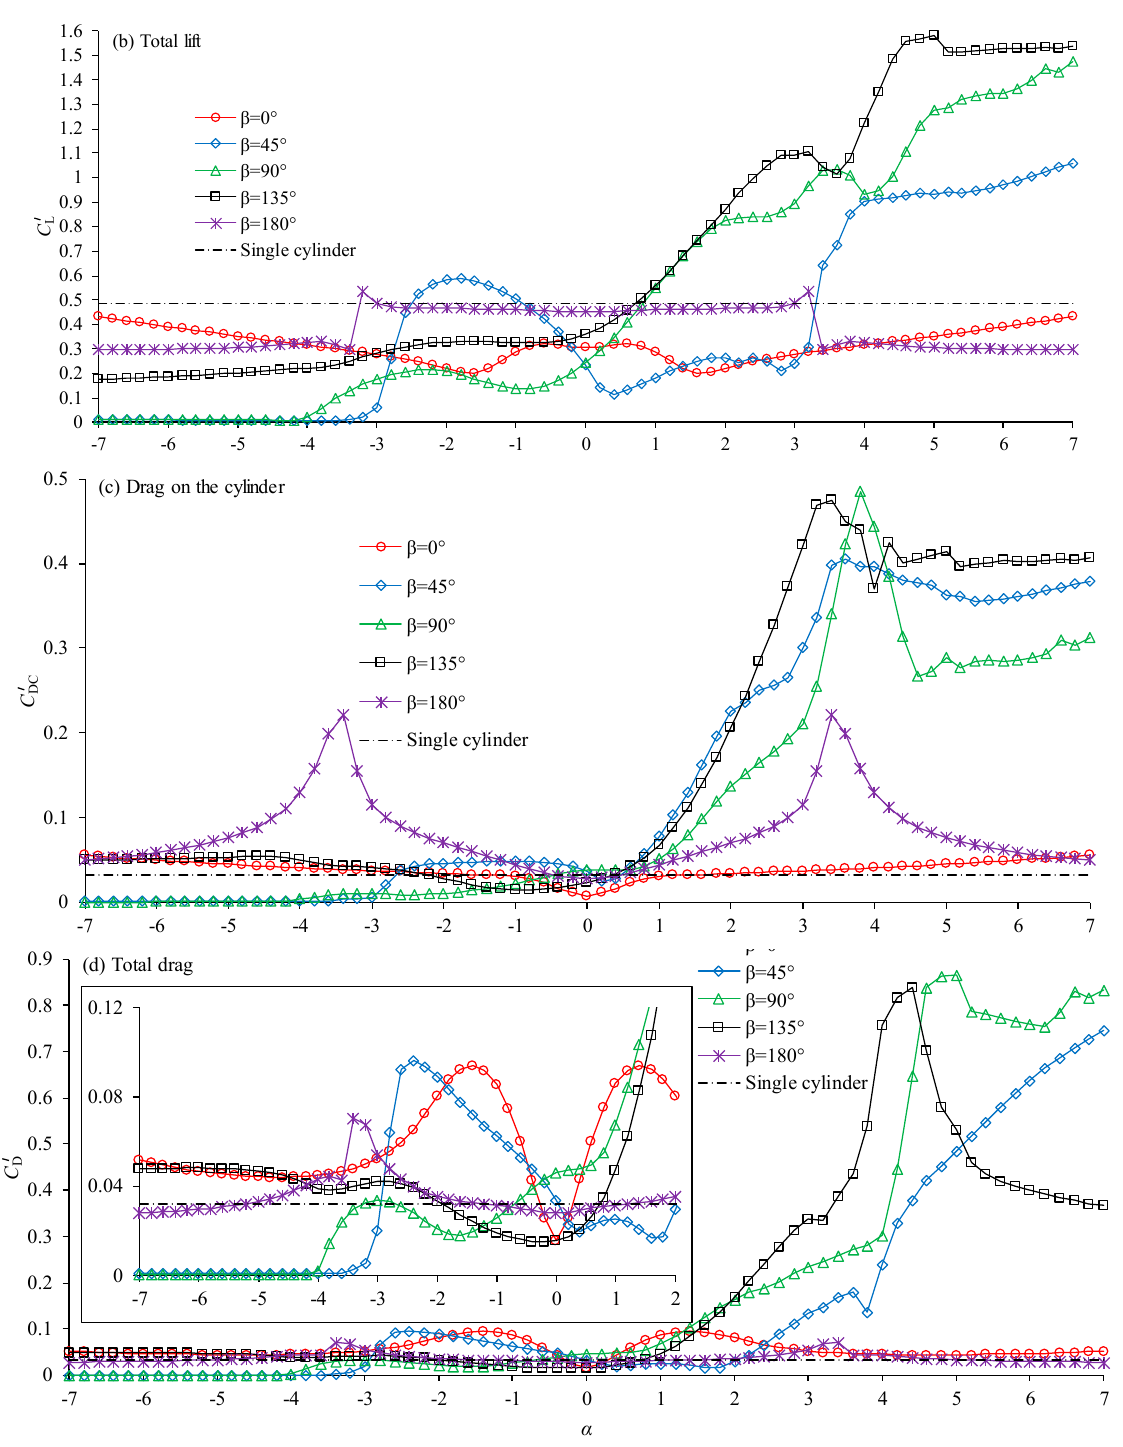
Figure 3. Variation of the drag and lift coefficients with α . To give a clear view of the very small SD of the drag coefficients for all the negative rotation rates, a view with a small vertical axis scale is presented in Figure 3d. It can be C ′ , in the range of 4 −≤α , was increased by around 50% to 100% for β = 0°, seen that D 135°, and 180°. However, the increase in the SD of the drag coefficient was minimal, since it was insignificantly smaller than the SD of the lift coefficient. The SD of the drag on the